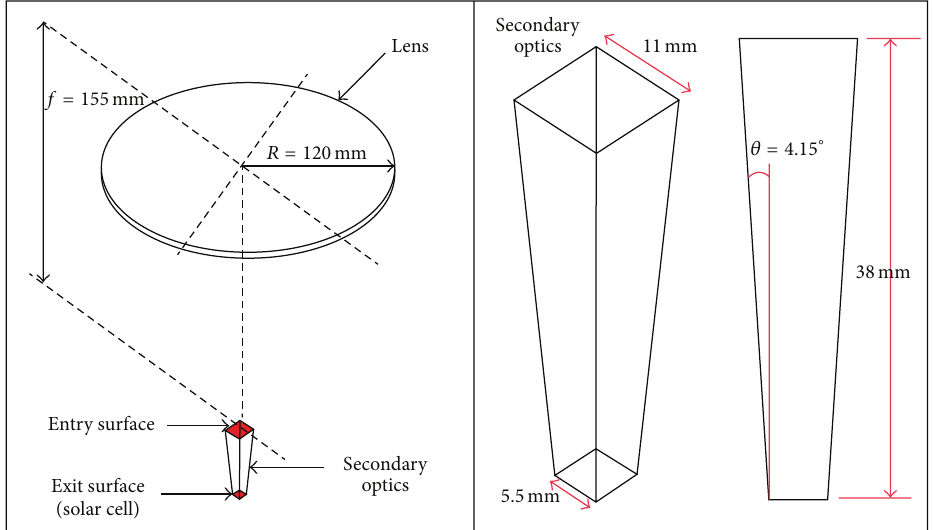
Figure 2: Optics sketch of the studied system.